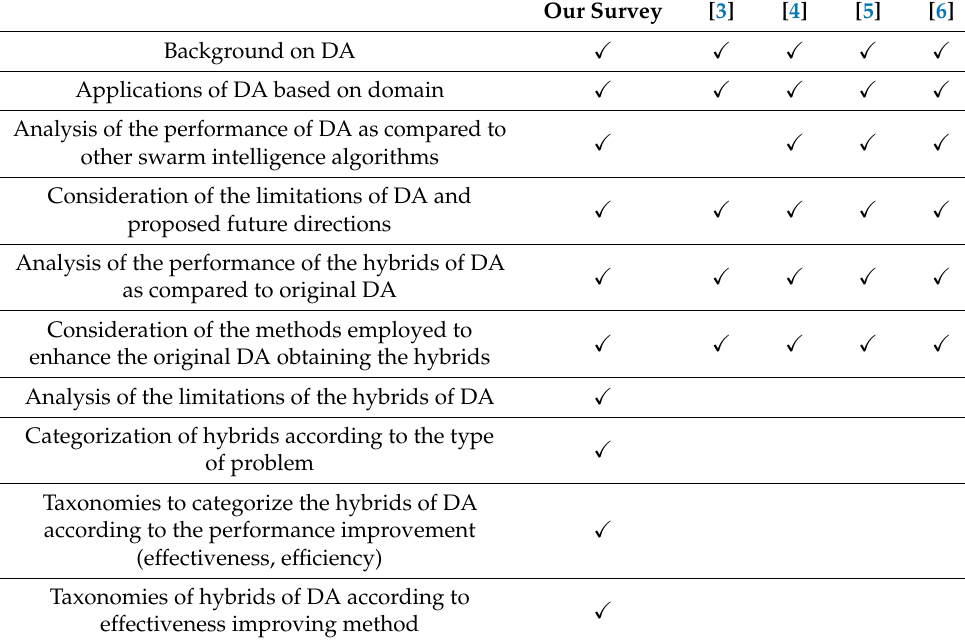
Table 1. Comparison between our survey and previous